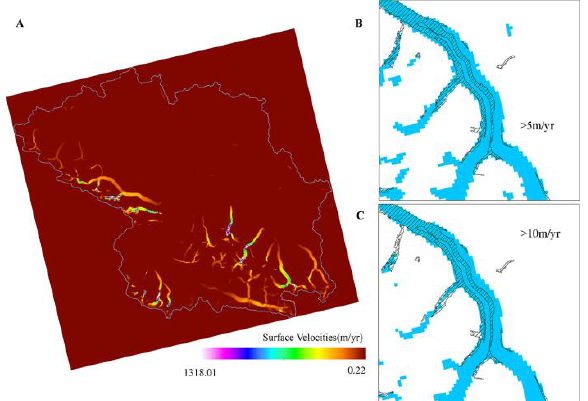
Figure 7. A) Mean surface velocity from 2011 to 2018. Data are from ITS_LIVE annual surface velocity products from the National Snow and Ice Data Centre. B) and C) are overlays of debris cover extent and area surface velocity > 5 m/yr and > 10 m/yr,